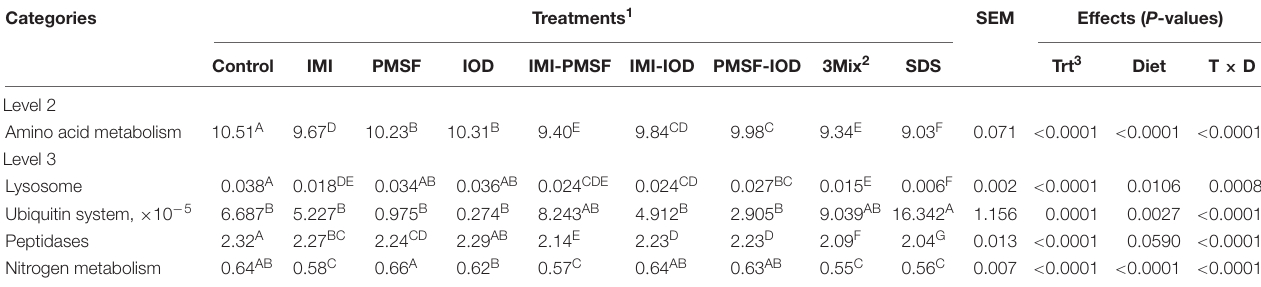
TABLE 5 | Relative abundance (% of total) of CowPI predicted functional features related to protein metabolism at 24 h of incubation.